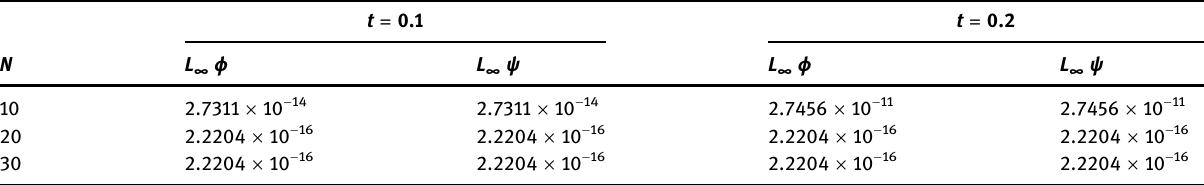
Table 5: L ∞ errors of ϕ and ψ components at di ff erent grid points regarding Example 3 t = 0.1 t =